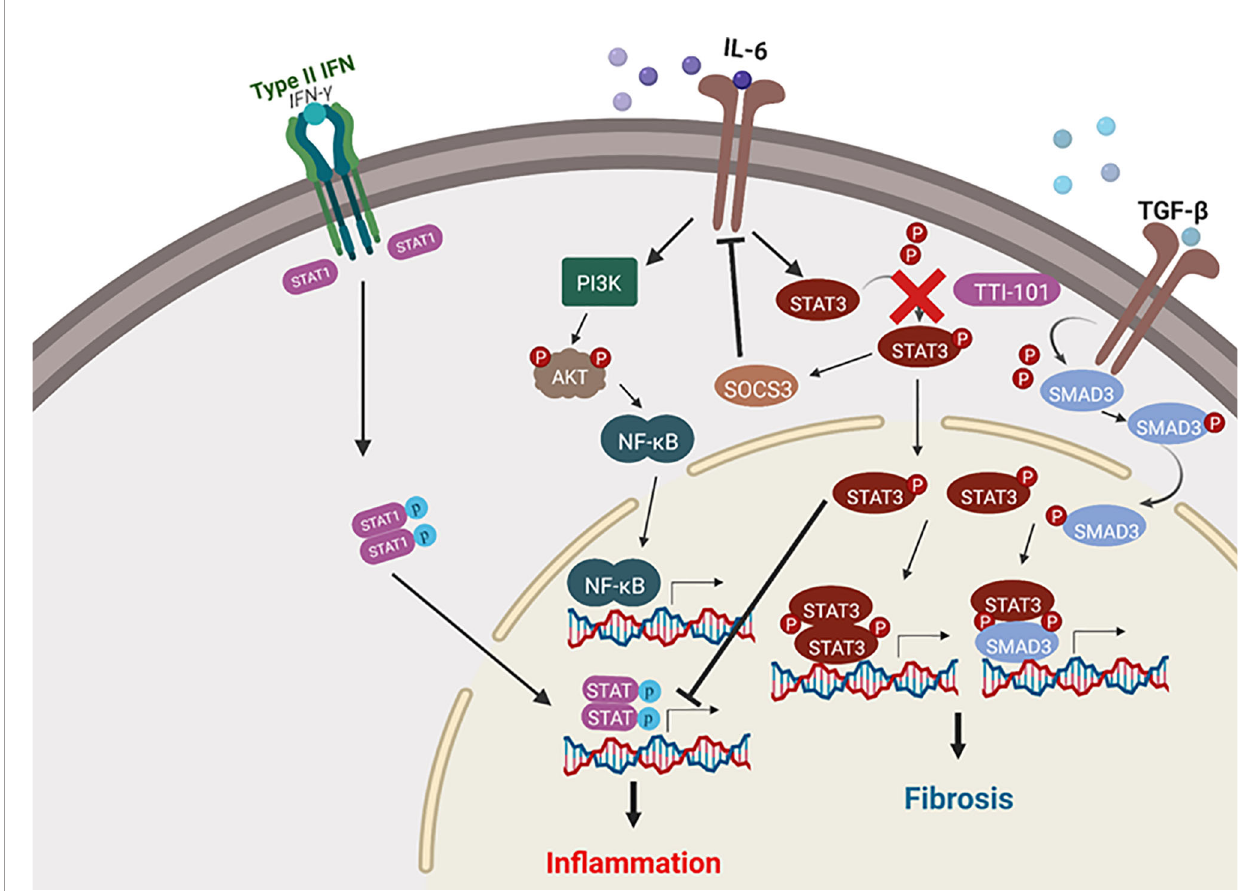
FIGURE 9 | Signal transducer and activator of transcription-3 (STAT3) activity in fi brosis and in fl ammatory signaling. Depicted are the pro-in fl ammatory and pro- fi brotic pathways in which STAT3 plays a role. Arrows represent upregulation of a pathway, while blunt lines represent downregulation of a pathway. Cardiac in fl ammation is modulated by STAT3 via suppression of both nuclear factor- k B (NF- k B) and STAT1 pro-in fl ammatory signaling. Cardiac fi brosis signaling is promoted by STAT3 through transforming growth factor beta (TGF- b )/SMAD signaling. The image was created with the assistance of